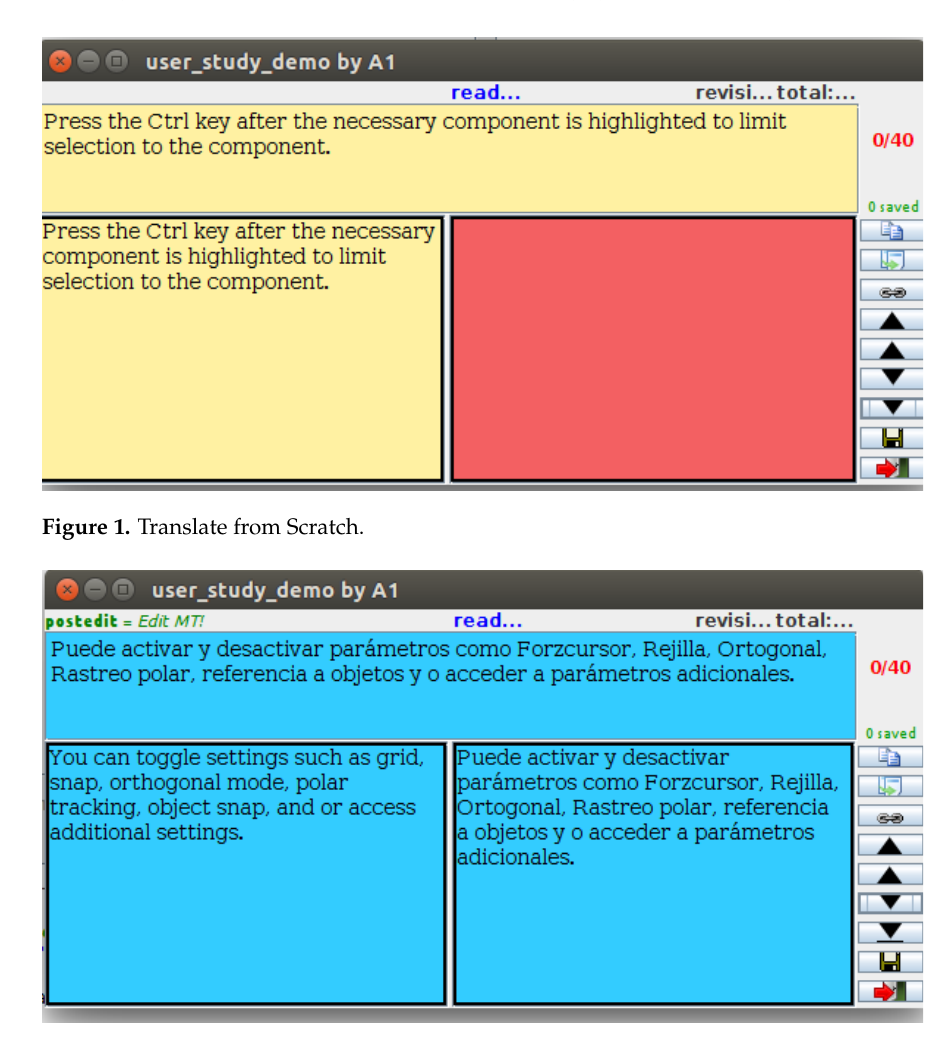
Figure 2. Postedit without